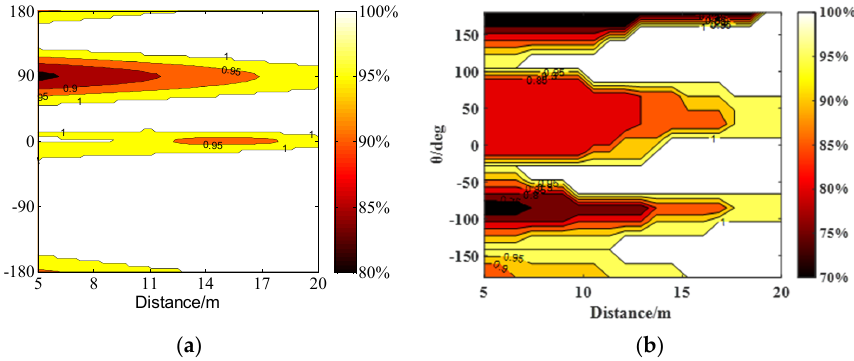
Figure 25. ( a ) Success tracking rate against distance in different DOAs (θ). ( b ) The success tracking rate of the patches antenna.